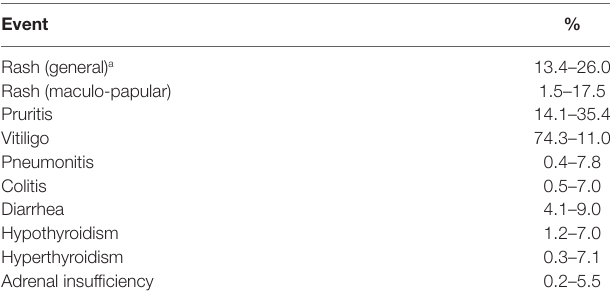
TABLe 3 | Severe immune-related adverse events associated with anti-CTLA-4 and anti-PD-1/-PDL-1 therapy. event % Rash (general) a